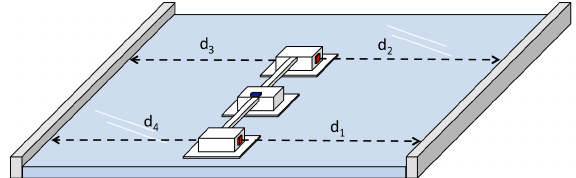
Figure 6. Sensor positions: The red mark refers to the distance sensor placement and the blue mark refers to